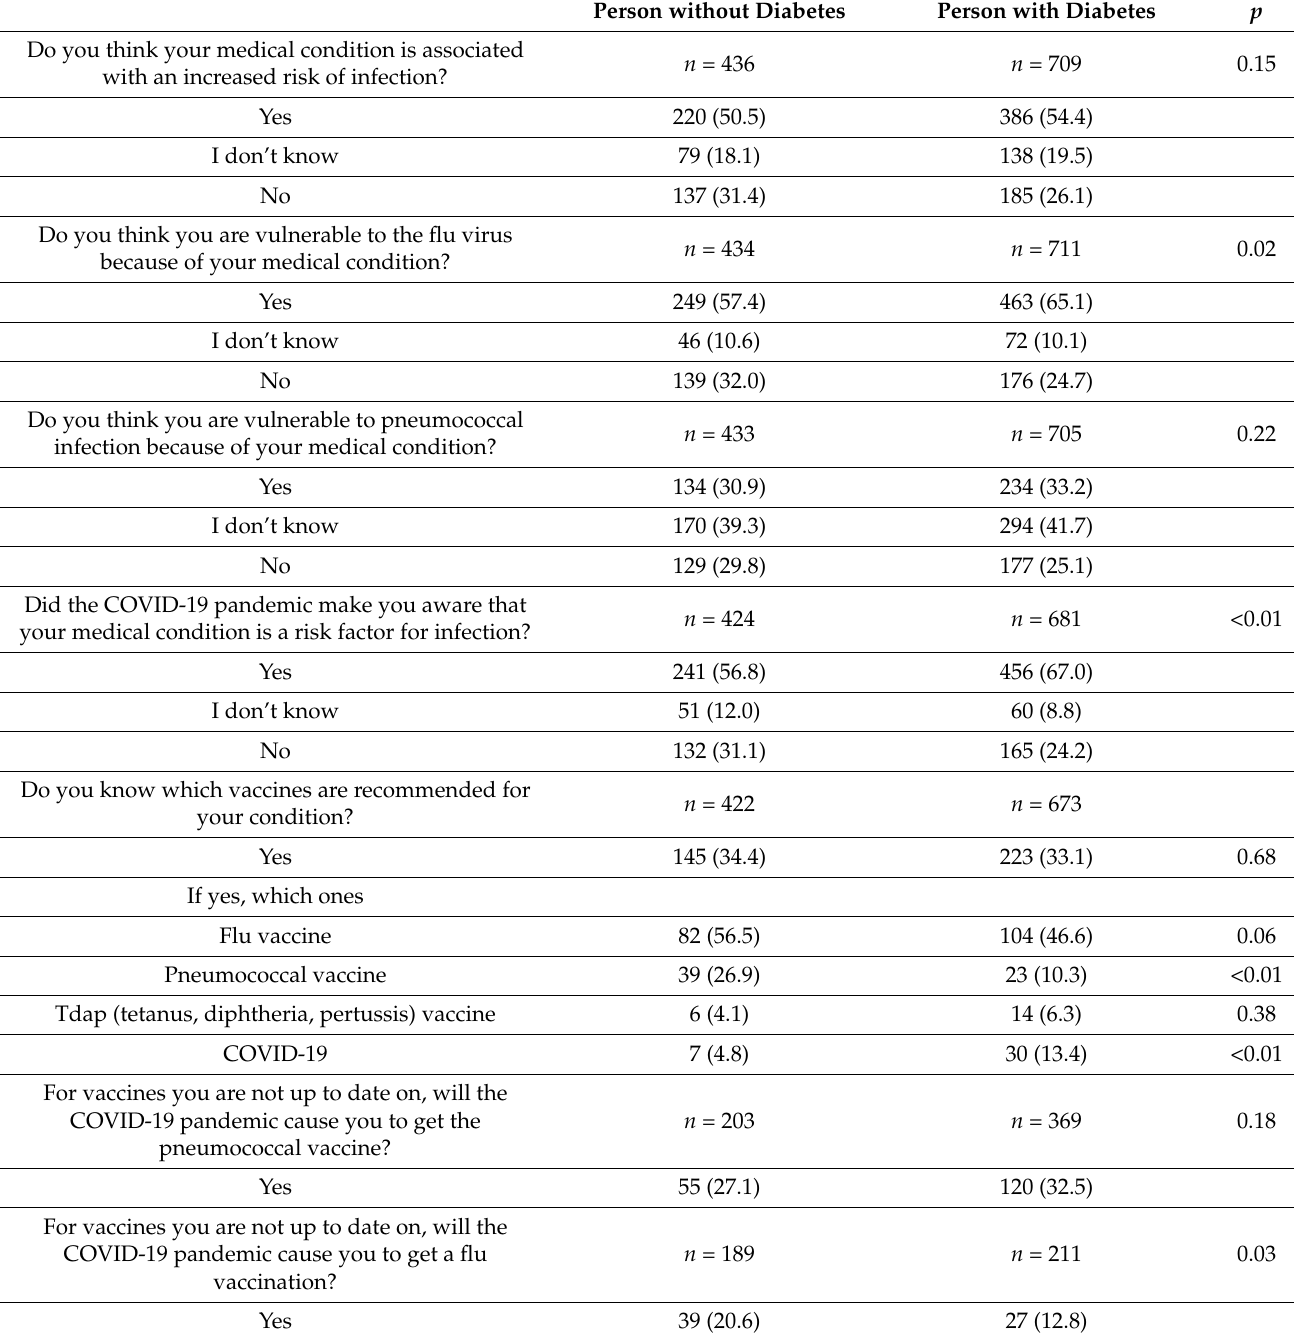
Table 2. Patient feelings about infectious risk and knowledge about